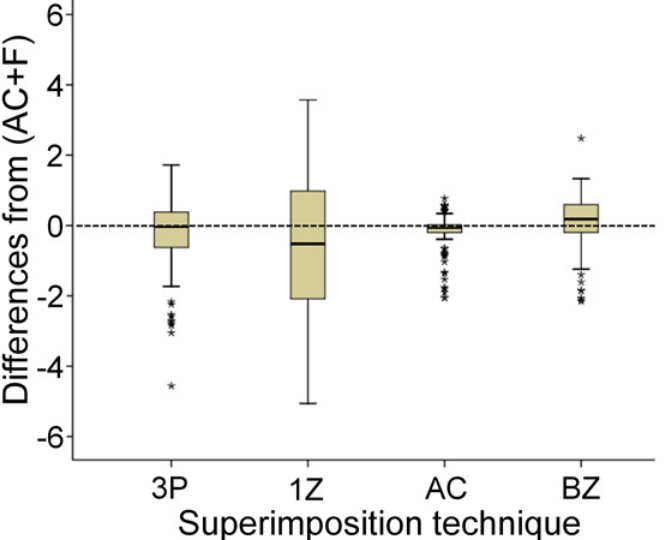
Fig 6. Differences in measured structural changes by each technique from the gold standard. Boxplots showing the medians and quartile distances (boxes: 25 th and 75 th percentage) of the differences in measured structural changes by each superimposition technique from the gold standard. The t-bars represent the smallest and largest value, provided there are no outliers. Outliers are considered values which lie above 1 ½ box lengths outside of the box and are shown as asterisks. (3P: three-point registration; AC: anterior cranial base; AC + F: anterior cranial base + foramen magnum; BZ: both zygomatic arches; 1Z: one zygomatic arch).